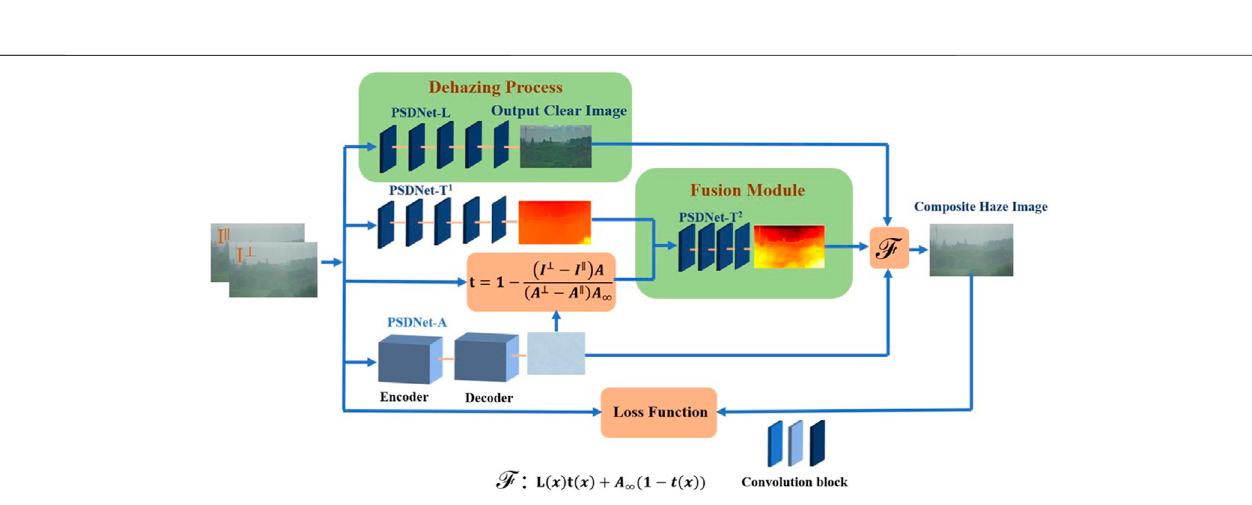
FIGURE 7 | Schematic diagram of